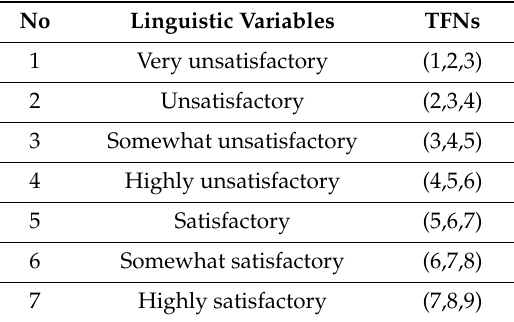
Table 5. The TFNs scale